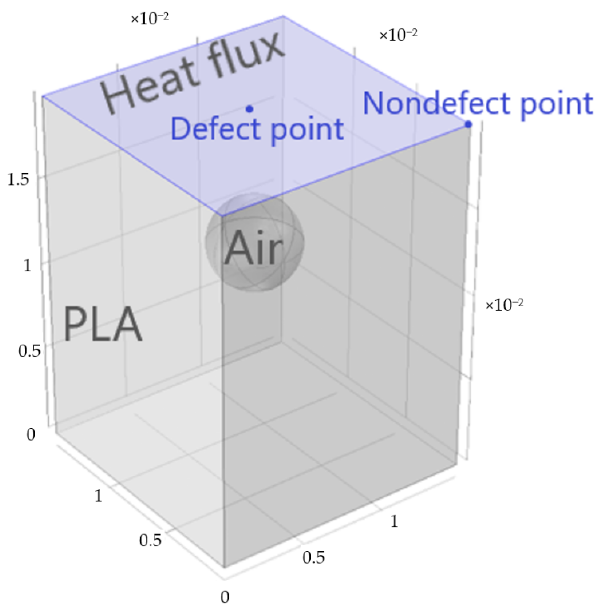
Figure 2. Numerical model of active thermal NDT (Comsol Multiphysics).